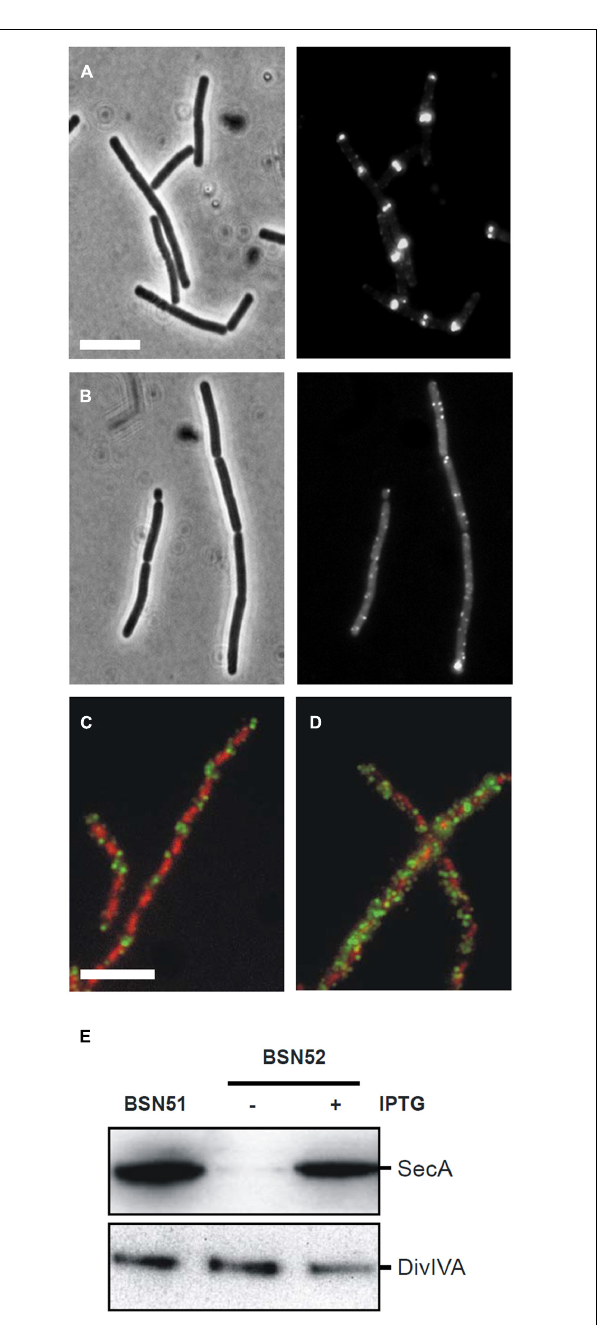
FIGURE 4 | Effect of SecA depletion on localization of DivIVA-GFP. (A,B) Localization of DivIVA-GFP in the secA depletion strain 4072 grown in the presence of 1 mM IPTG (A) or in the absence of IPTG (B) .The corresponding phase contrast images are presented in the left panels. (C,D) Localization of untagged DivIVA after SecA depletion. Localization of DivIVA in the secA depletion strain BSN52 grown with 1 mM IPTG (C) or without the inducer (D) . DivIVA localization was analyzed by immunofluorescence microscopy using the DivIVA antiserum 2 h after induction with 0.5% xylose. Note that longer induction times would be required for full complementation of the filamentous (cid:3) divIVA phenotype. Merged images are composed of red DAPI stained nucleoids and green DivIVA. Depletion of SecA and normal DivIVA expression was confirmed by Western blot analysis (E)